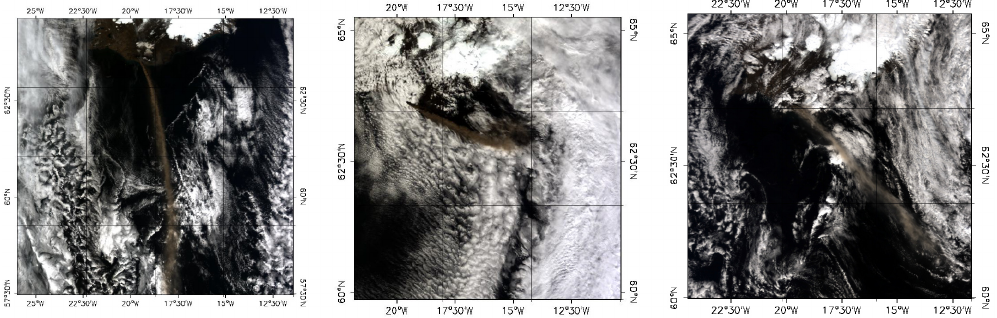
Figure 2. Validation MODIS images RGB (R = ch1, G = ch4, B = ch3), used in this study. From left to right: 11 May 2010, 14:05UTC; 12 May 2010, 12:55UTC; 16 May 2010,